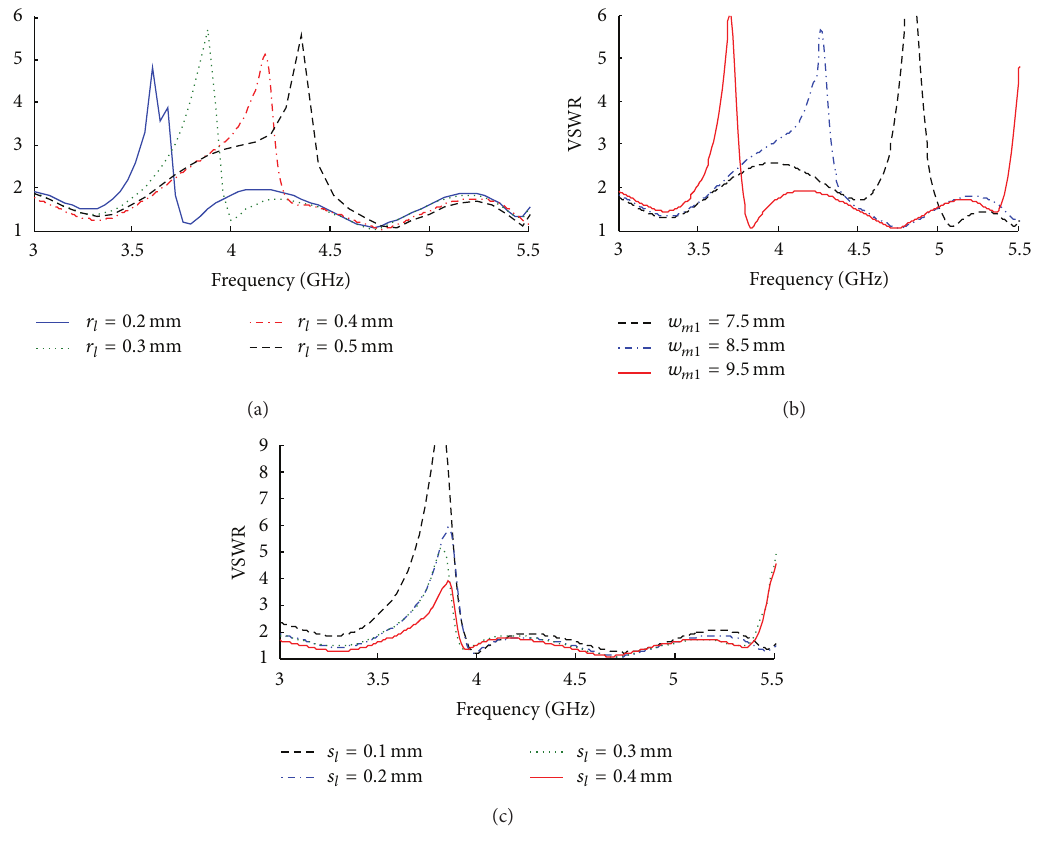
Figure 3: Effect of changing EBG 1 (a) radius 𝑟 𝑙 , (b) width 𝑤 𝑚1 , and (c) 𝑠 𝑙 .